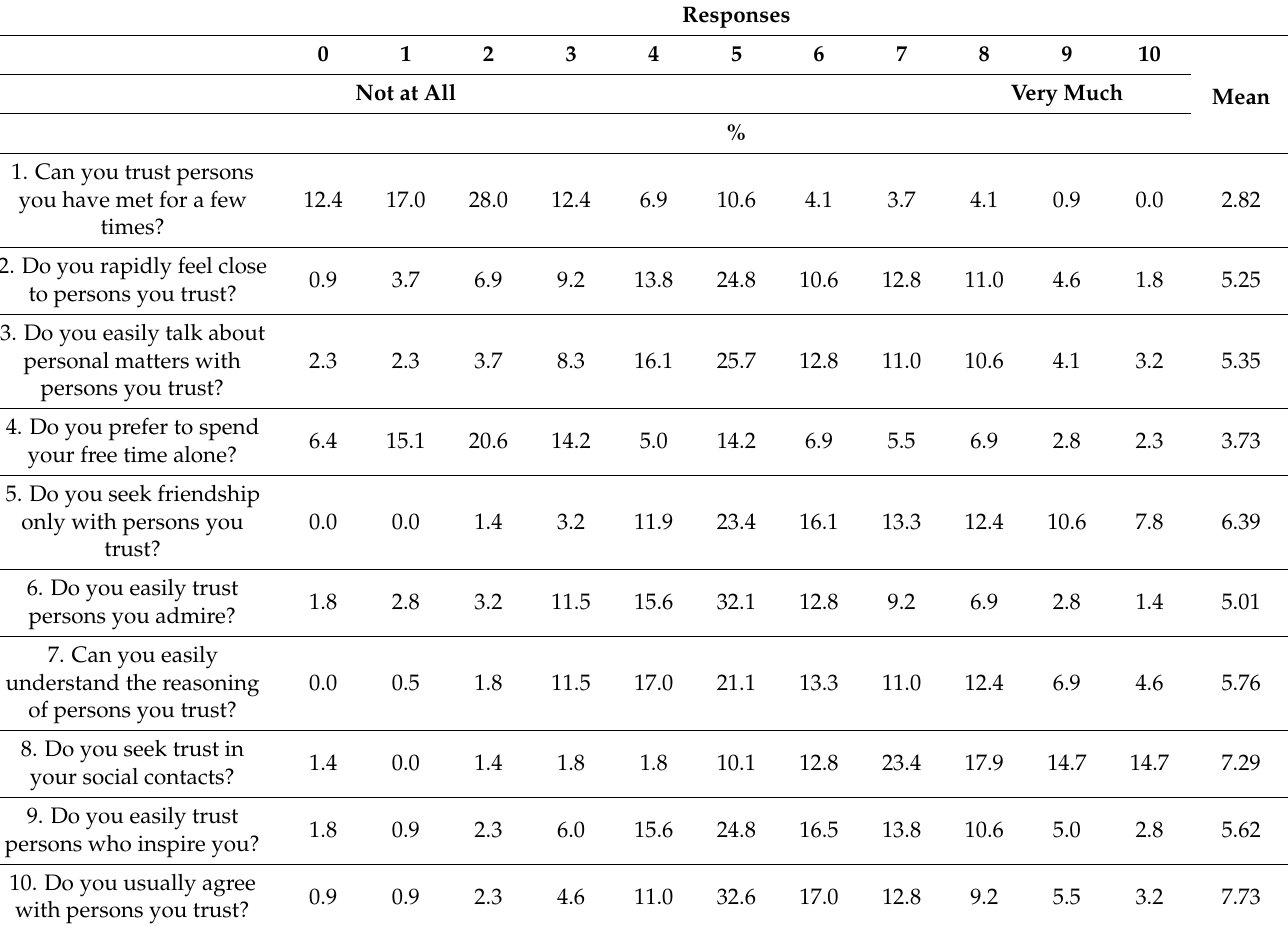
Table 2. Frequency responses and mean levels of 218 participants on ‘Scale of Personal Trust and Connections, PerTC’